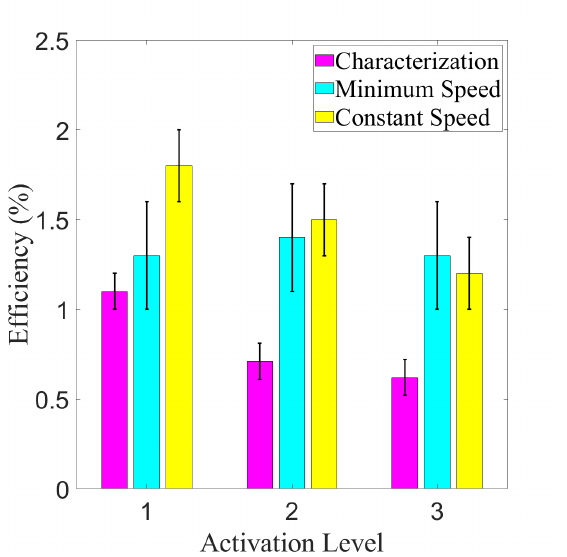
Figure 16. Efficiency of the actuator during isotonic contractions compared to activation level, for the stroke characterisation experiment, minimum contraction period experiment, and constant contraction period experiment. Significance in differences not displayed due to